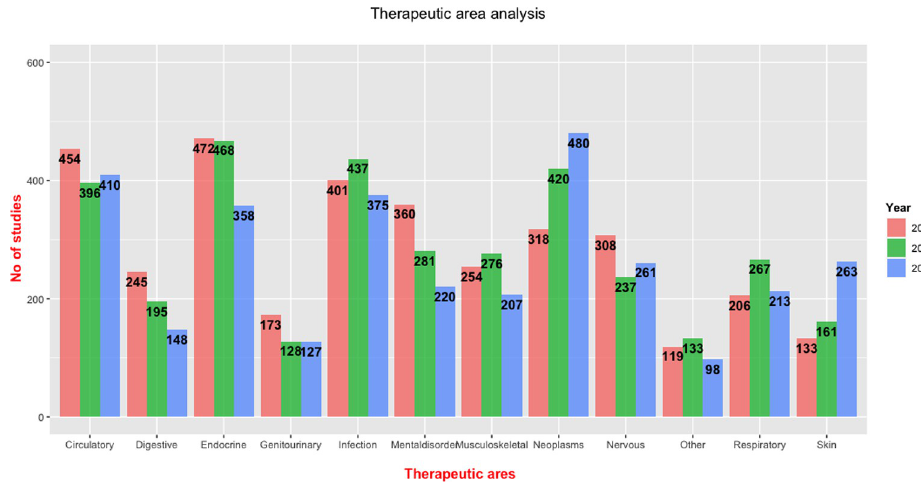
Fig 6. Distribution of therapeutic area in clinical trials from